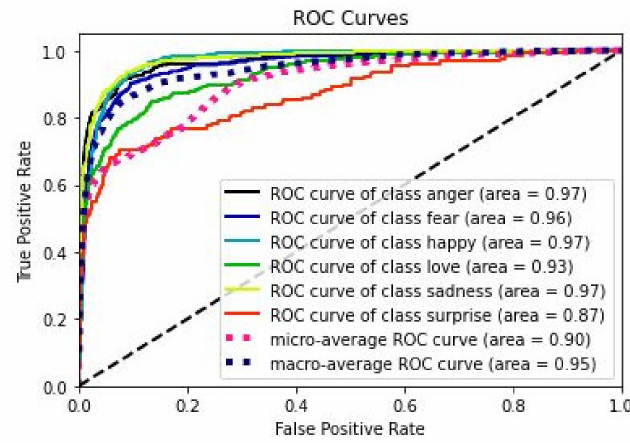
Figure 6. MultinomialNB ROC—emotions classification.